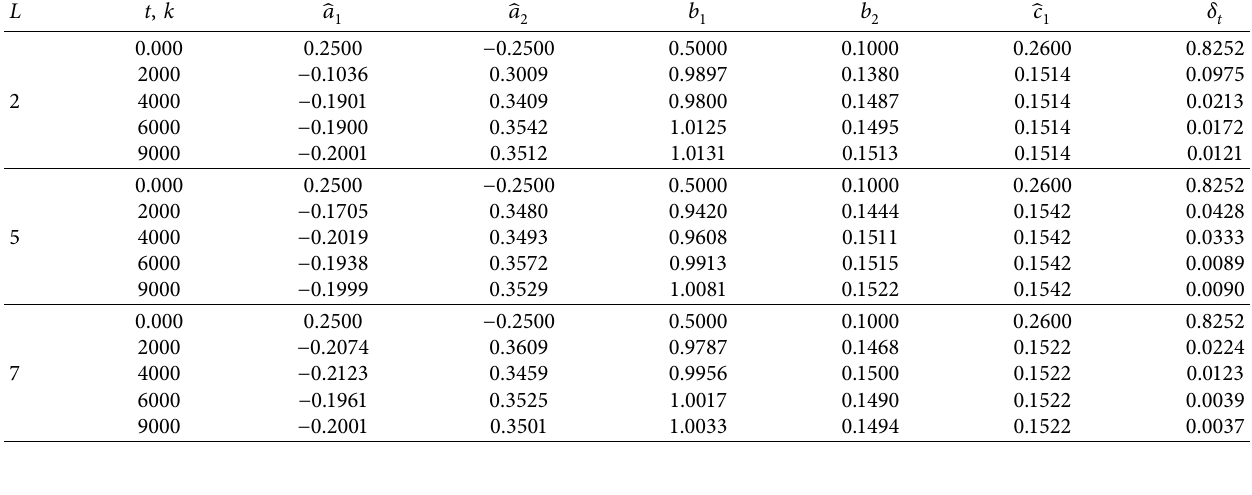
t and their parametric errors δ t for the FSOEAHW model using MIIBPG algorithm with L